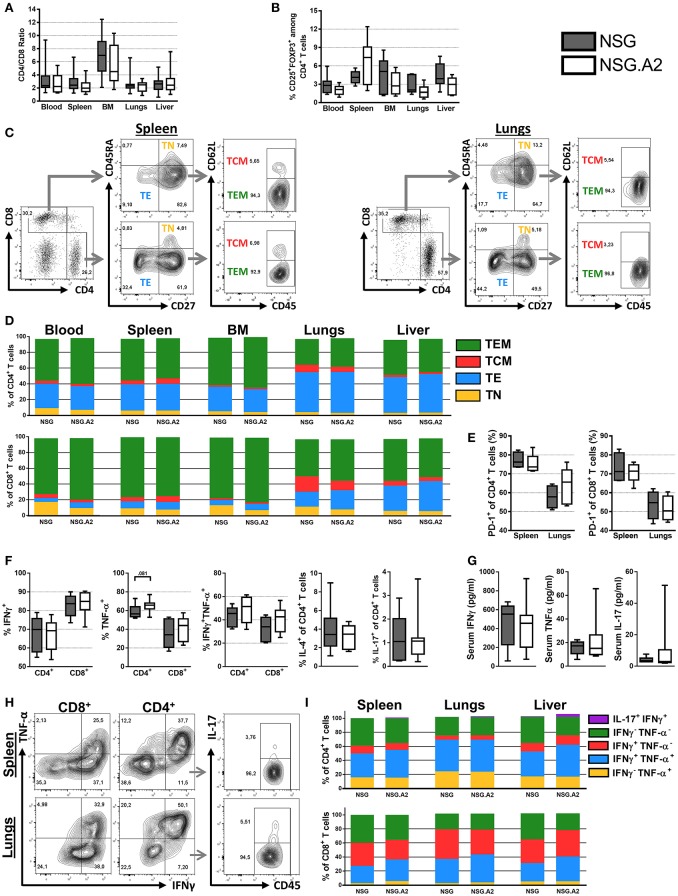
Differentiation and phenotype of human T cells in NSG and NSG-HLA-A2/HHD mice transplanted with non-HLA-A2 PBMCs. NSG and NSG-HLA-A2/HHD (NSG.A2 in figure) mice were transplanted with HLA-A2− PBMCs and were sacrificed at day 14 to collect their organs and perform flow cytometry analyzes. (A) CD4/CD8 ratio in indicated organs (11 mice/group). (B) Frequency of Treg in the different organs (11 mice/group). (C) Representative FACS plots and gating strategy of the data shown in panel D. (D) Mean frequency of naive (TN, CD45RA+CD27+), effector (TE, CD45RA−CD27−), central memory (TCM, CD45RA−CD27+CD62L+) and effector memory (TEM, CD45RA−CD27+CD62L−) T cells (11 mice/group). (E) Frequency of PD-1+ T cells (4–5 mice/group). (F) Frequency of IFNγ+, TNF-α+, IFNγ+TNF-α+, IL-4+, and IL-17+ T cells in spleen (11 mice/group). (G) Serum concentration of IFNγ, TNF-α and IL-17 cytokines, assessed by bioplex (6–7 mice/group). (H) Representative FACS plots and gating strategy of the data shown in panel I. (I) Mean frequency of IFNγ−TNF-α+, IFNγ+TNF-α+, IFNγ+TNF-α−, IFNγ−TNF-α−, and IL-17+IFNγ+ T cells (4–5 mice/group). Data in A, B, E, F, and G show the median, 25 and 75th percentiles of the distribution (boxes), and whiskers extend to the 5 and 95th percentiles.